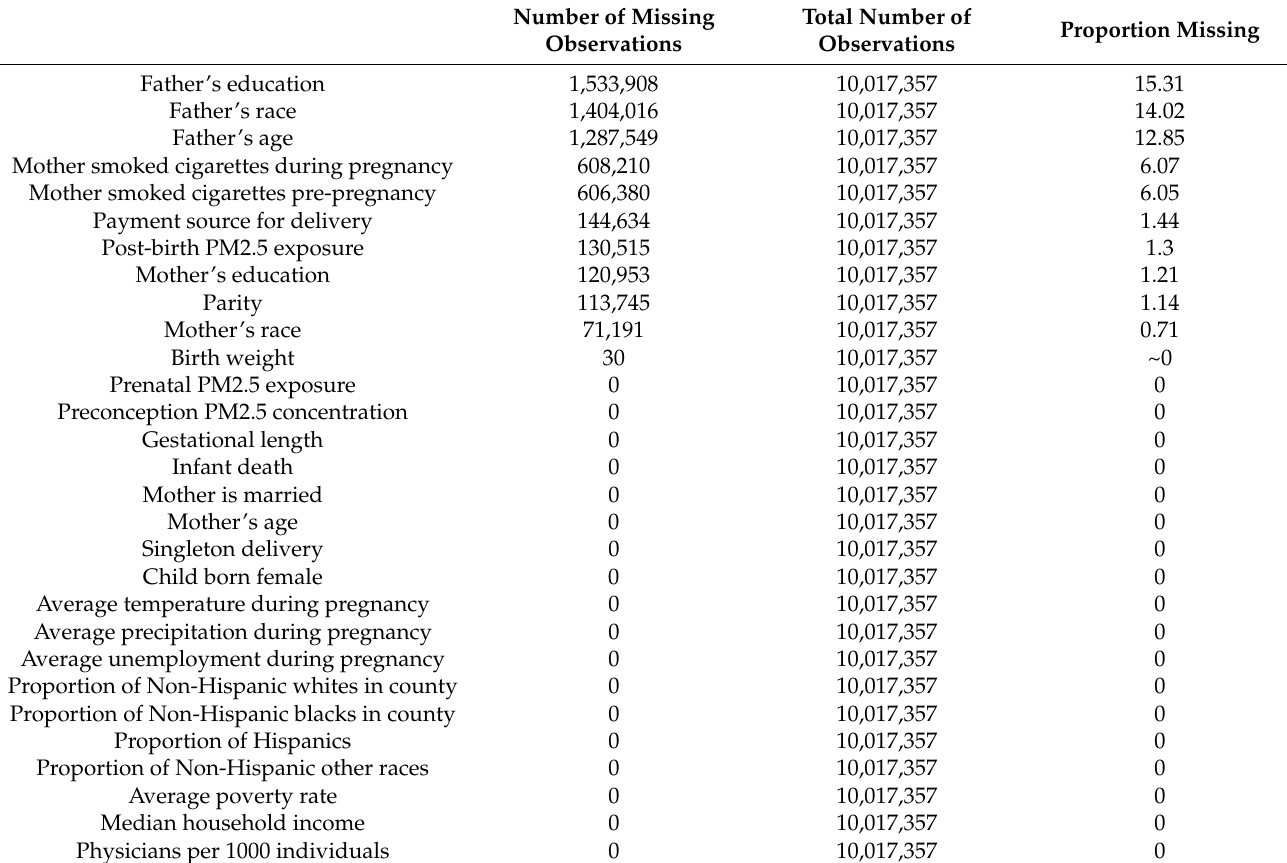
Table A3. Frequency and proportion of missing data among variables in the analytic sample. Number of Missing Observations